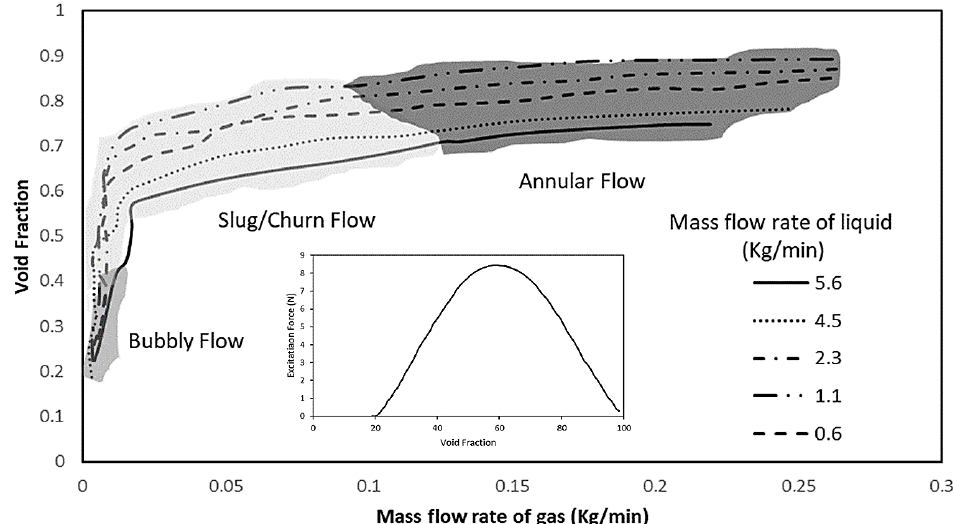
Figure 5. Relationship between void fraction with liquid and gas flowrates, and flow regimes and excitation forces.